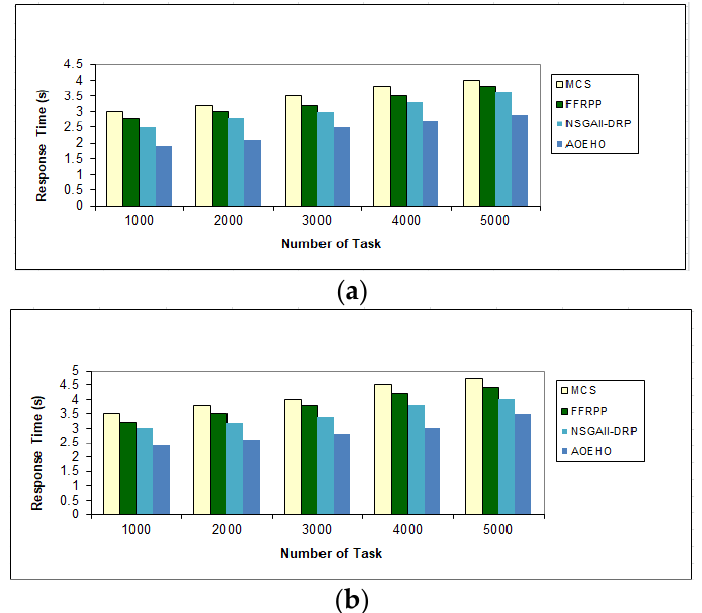
Figure 5. Response time of tasks = 5000 tasks. ( a ) Size of data replication = 64 MB. ( b ) Size of data replication = 320 MB.